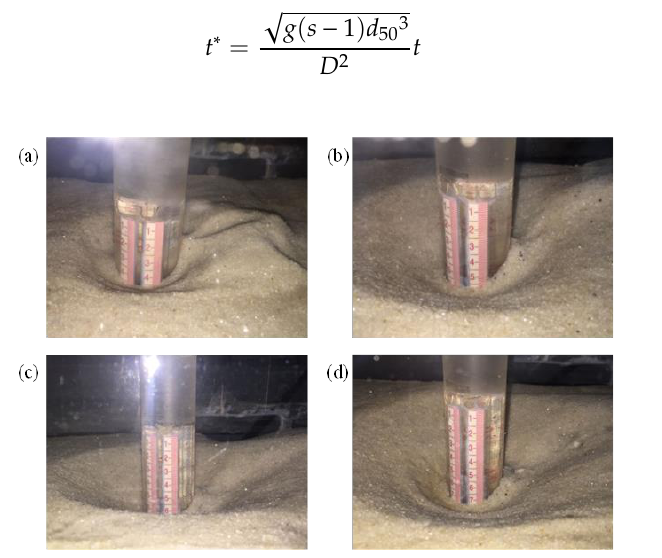
Figure 2. Photographs of local scour hole around the pier at the time of ( a ) t* = 11; ( b ) t* = 133; ( c ) t* = 266; and ( d ) t* = 931.